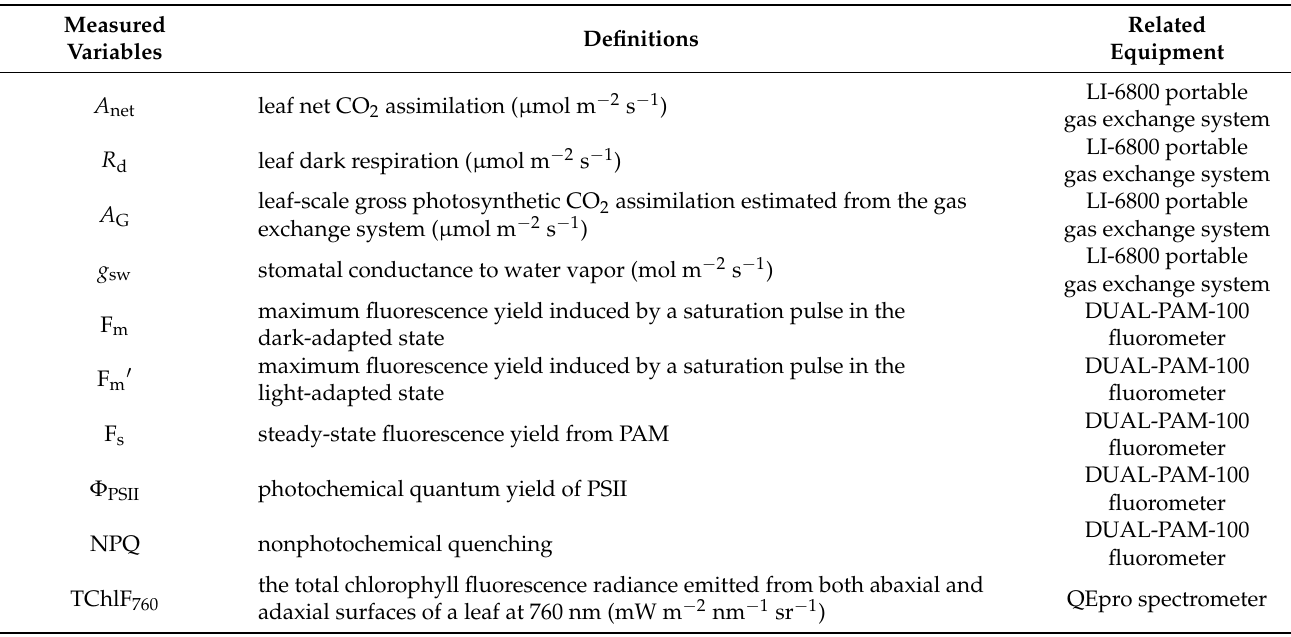
Table 1. Measured variables and related equipment used in this